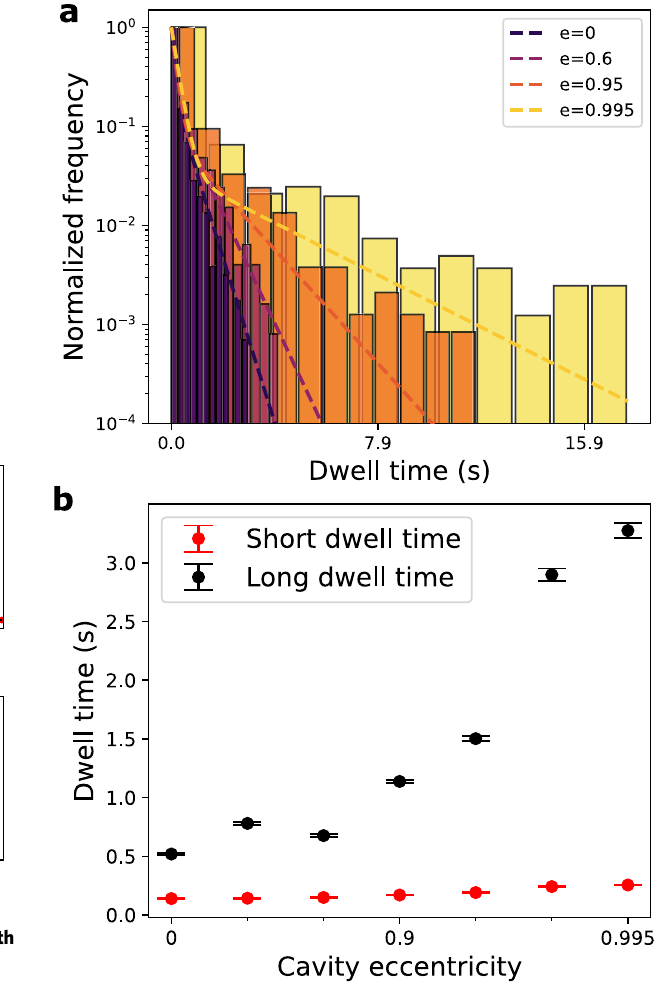
Fig. 6 Dwell time analysis of a cavity con fi ned plasmid in presence of T 4 -DNA. a Dwell time histograms for cavities of varying eccentricity with double-exponential fi ts. b Resulting average dwell times extracted from double exponential fi ts to dwell-time histograms, with the black circles corresponding to the long average dwell-time and the red circles corresponding to the shorter average dwell time. The error bars denote the covariance from the fi